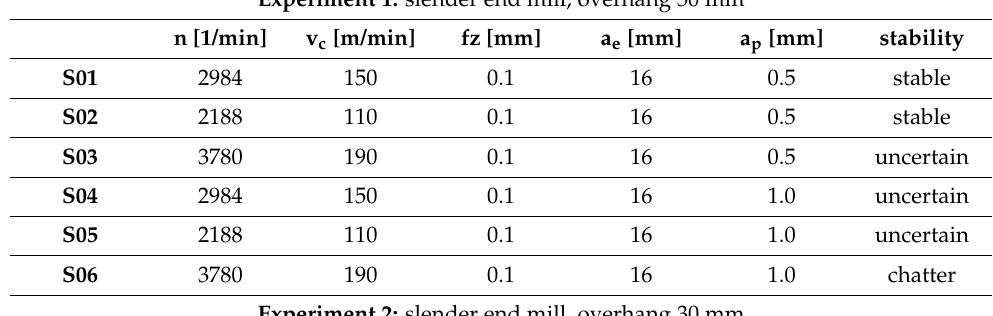
Table A1. Cutting conditions for all performed tests. Stability is the evaluation based on the surface